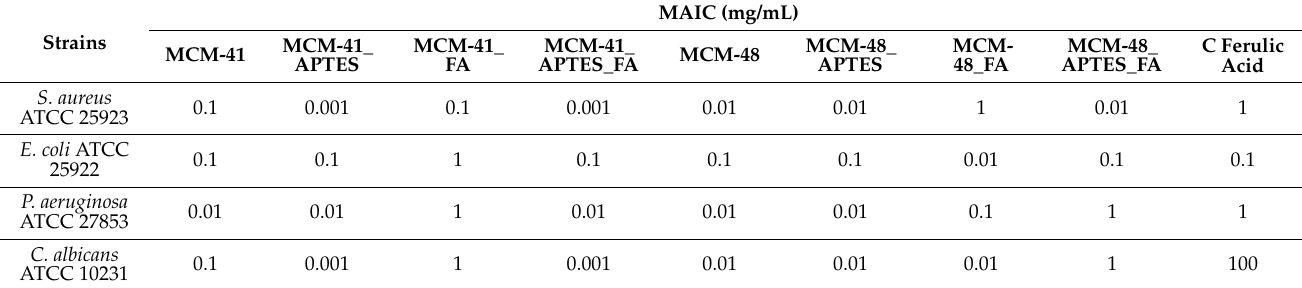
Table 6. Determination of minimum adhesion inhibition concentration